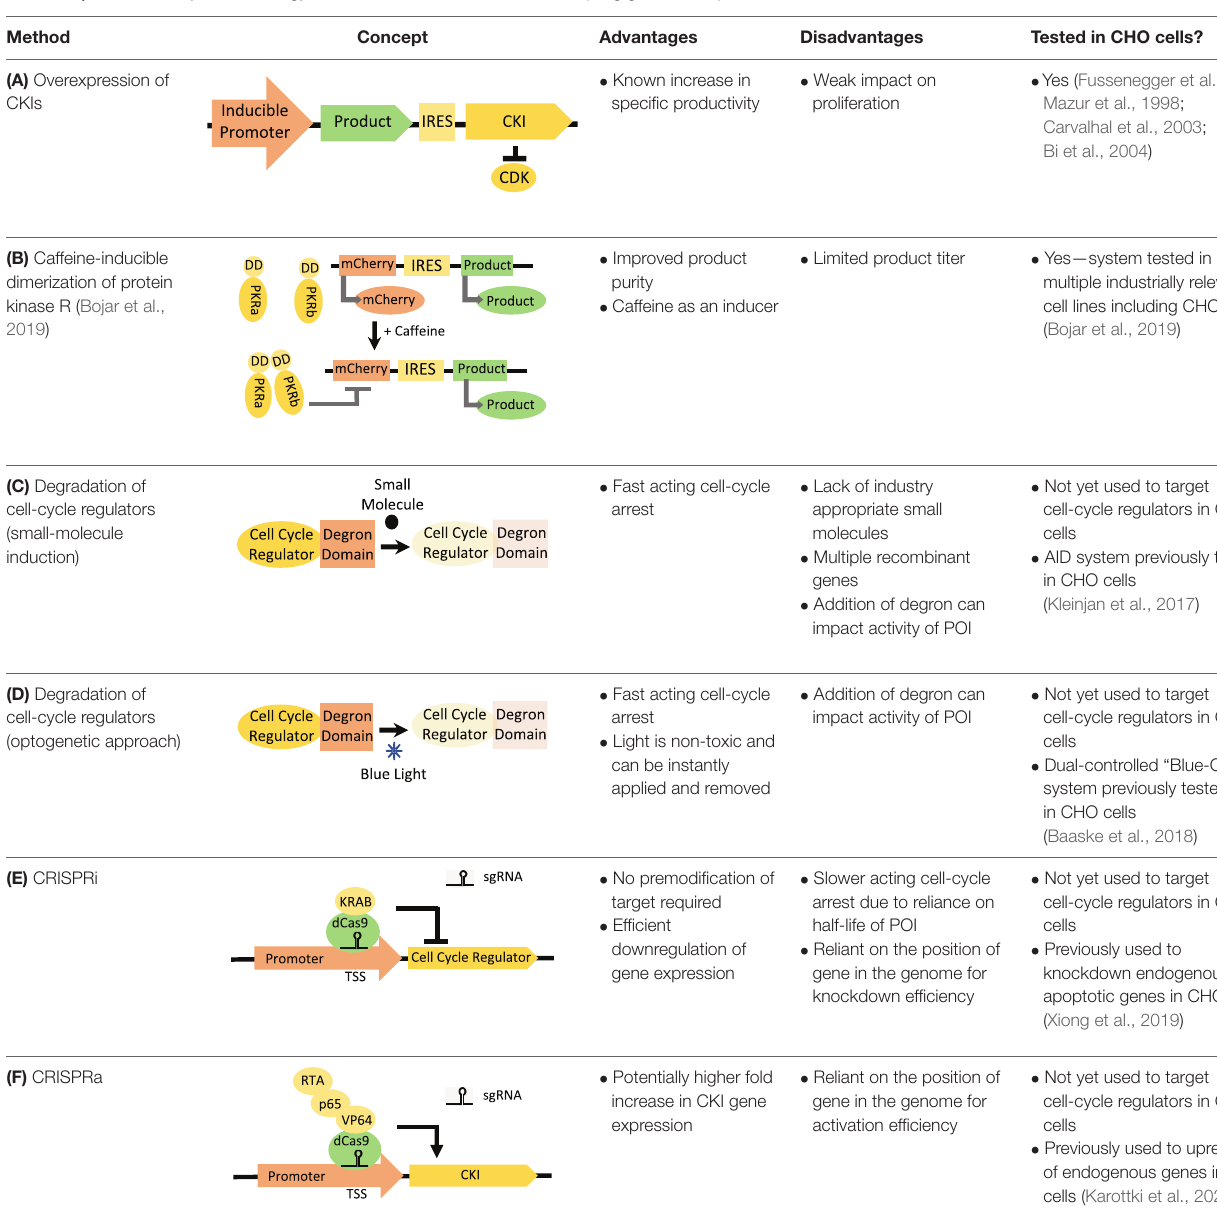
TABLE 1 | Mammalian synthetic biology tools which could be used for decoupling growth and